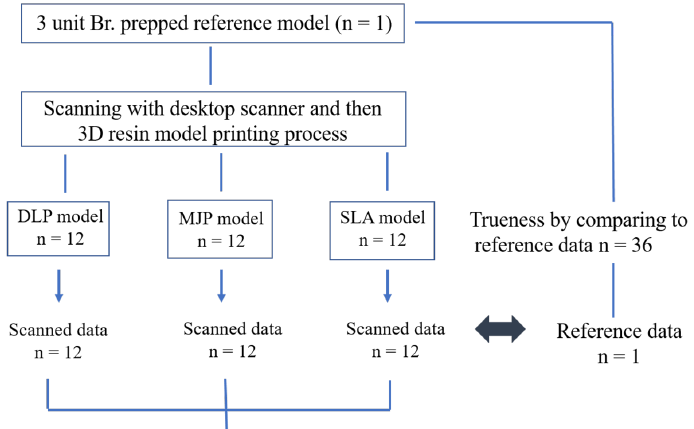
Figure 1. Flow chart of this study. 3D, three-dimensional; DLP, digital light processing; MJP, Multi-Jet printing; SLA, stereo-lithography apparatus. Materials 2021 , 14 , x